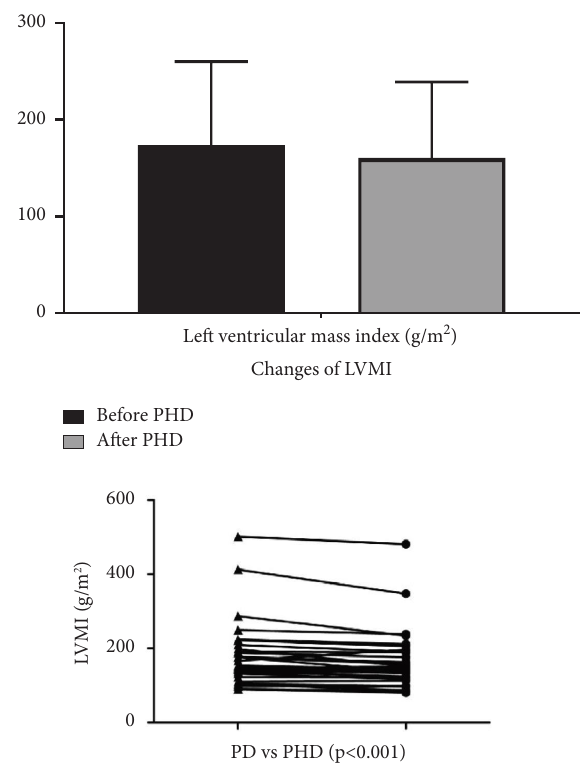
Figure 4: Comparison of left ventricular mass index results before and after PHD ( p < 0 . 001). Table 4: Univariate and multivariate analysis of factors (after PHD) associated with LVMI